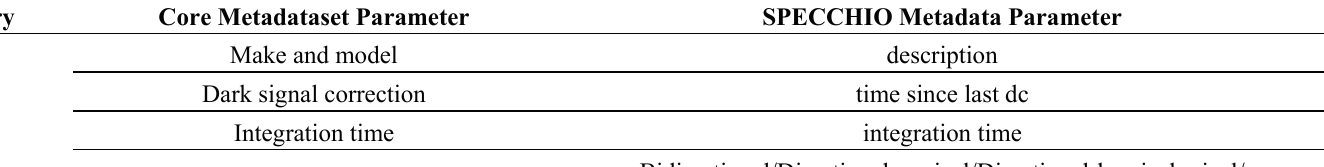
Table 2. Mappings between core metadataset parameters and SPECCHIO